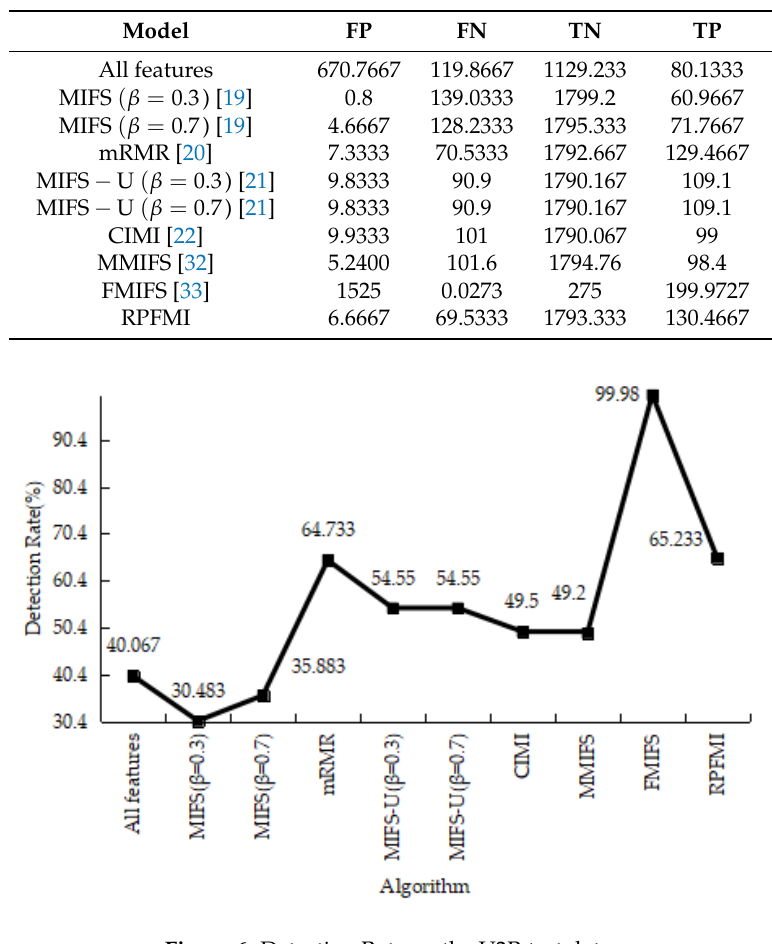
Figure 7. False Positive Rate on the U2R test data.